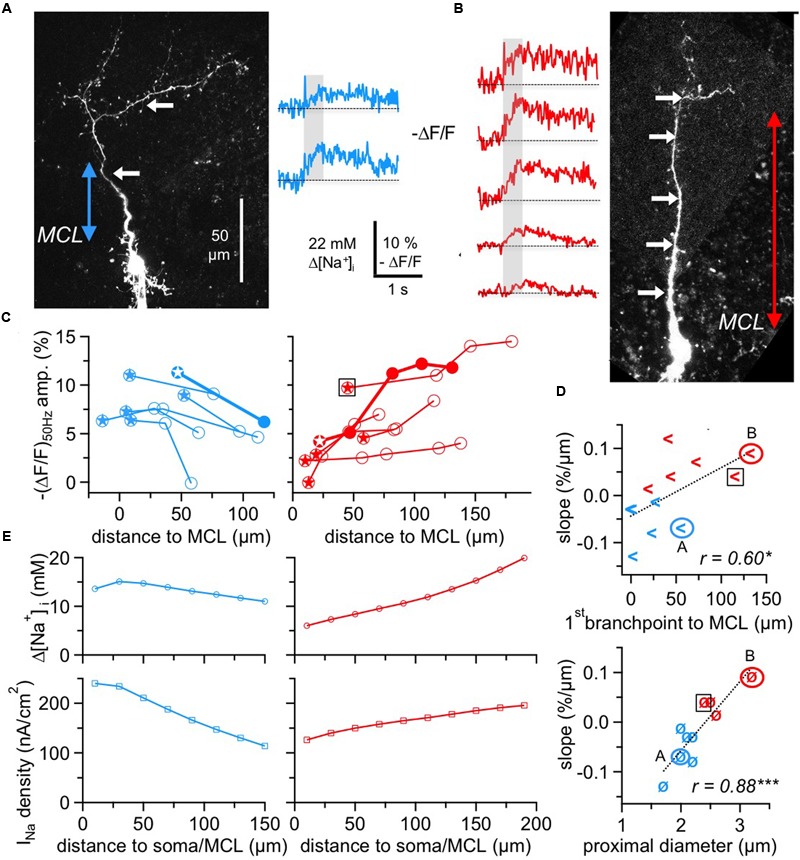
Two subtypes of GC Na+ signals versus dendritic distance. (A,B) Two-photon scans of GCs representative for the decreasing subtype (left panel, blue transients) and for the increasing subtype (right panel, red transients) with averaged fluorescence transients in response to 50 Hz AP trains imaged at the locations indicated by the white arrows. The colored arrows in the scans indicate the distance from the lower MCL border as established in the infrared scan to the first branch point of the apical dendrite. Train durations are indicated by the gray boxes. (C) Cumulative plots of (ΔF/F)50Hz amplitudes vs. distance from MCL border for the decreasing (left panel, n = 6 cells) and increasing (right panel, n = 6 cells) subtype, respectively. All data points belonging to the same GC are interconnected by lines. The data of the cells shown in (A,B) are indicated by solid symbols and thick connecting lines. Stars indicate the most proximal measurement for each cell. The open black square denotes the GC that was not clustered with the other cells with positive slope (see Results). (D) Top panel: Plot of the cell-wise slope of (ΔF/F)50Hz/distance from MCL versus the distance of the respective GC’s first branch point from MCL. Bottom panel: Plot of the cell-wise slope of (ΔF/F)50Hz/distance from MCL versus the diameter of the proximal dendritic segment. Again, the open black squares denote the GC that was not clustered with the other cells with positive slope. (E) Simulation of Δ[Na+]i (top panels) and the associated Nav current density INa (bottom panels) in a simple compartmental model of the apical dendrite, with an initial diameter of 2.0 μm for the decreasing and of 2.7 μm for the increasing cell type, both tapering linearly to 1.2 μm over 200 μm. INa was adjusted to match the average experimental [Na+]i for the respective cell type from panel C above (see Materials and Methods). ∗P < 0.05; ∗∗∗P < 0.005.